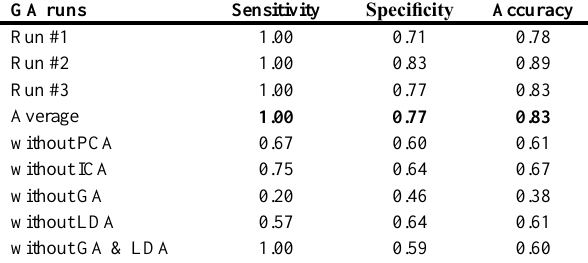
Table 2. Evaluation of classification performance.